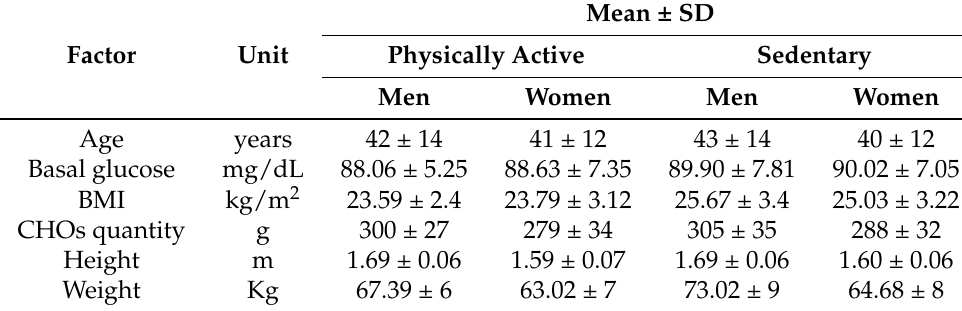
Table 4. Personal factors of the developed virtual